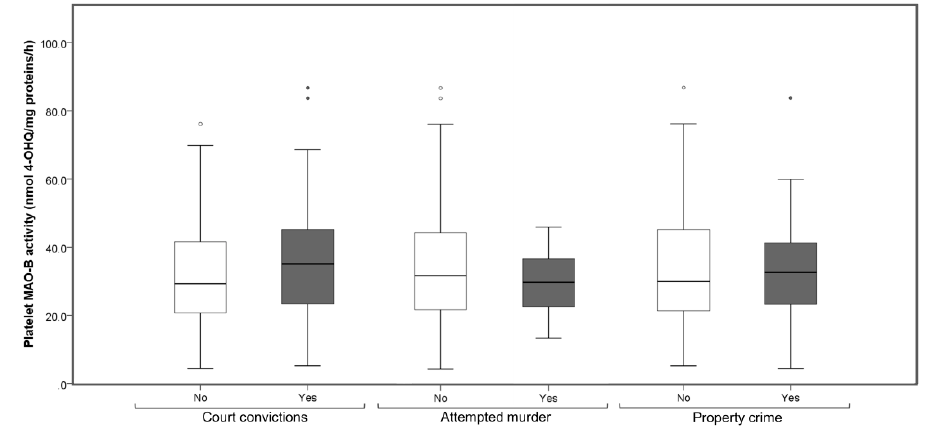
Figure 2. Platelet MAO-B activity in subjects detained in a juvenile correctional facility, subdivided into youths with or without court convictions, detainees with or without a record of attempted murder or detainees who committed or who did not commit property crime. Results are presented as a box and whisker plot. The median is represented by the line in the box, while the interquartile range (IQR) box represents the middle quartiles (the 75th minus the 25th percentile). The whiskers on either side of the IQR box represent the lowest and highest quartiles of the data. The ends of the whiskers represent the maximum and minimum of the data, while the individual dots beyond the whiskers represent outliers in the data set.